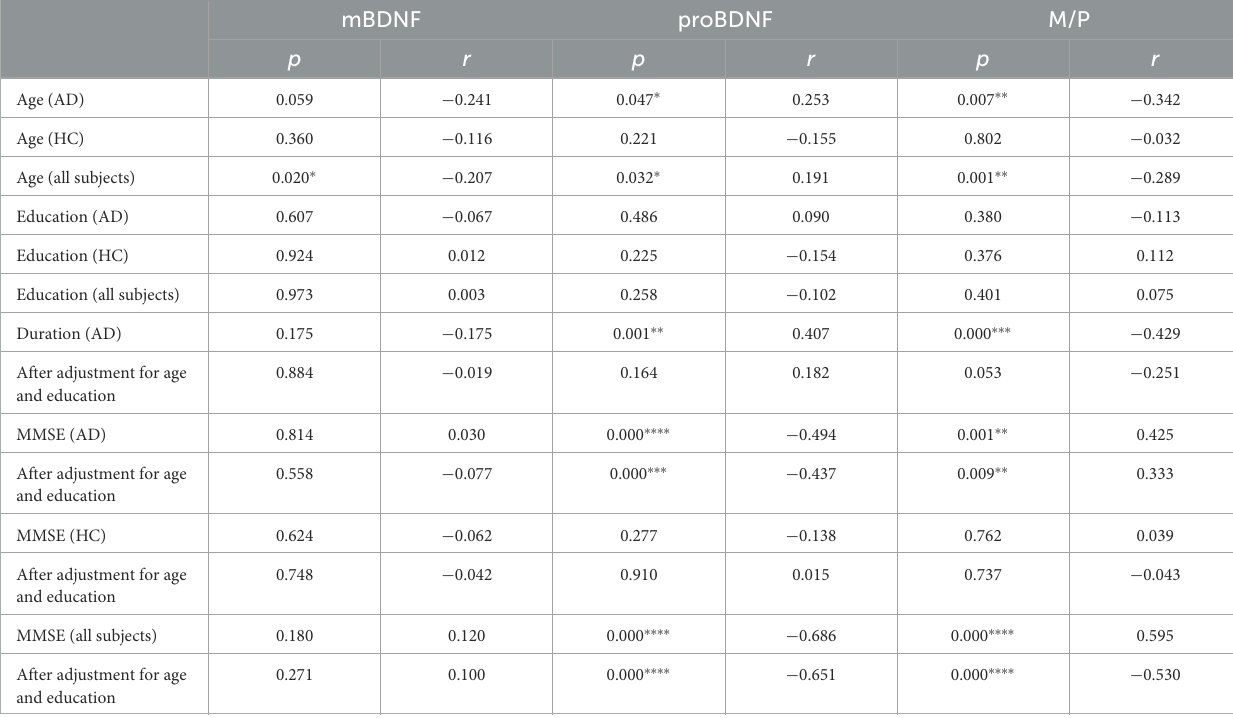
TABLE 2 Correlation analysis among mBDNF, proBDNF, M/P ratio, demographic data, and clinical